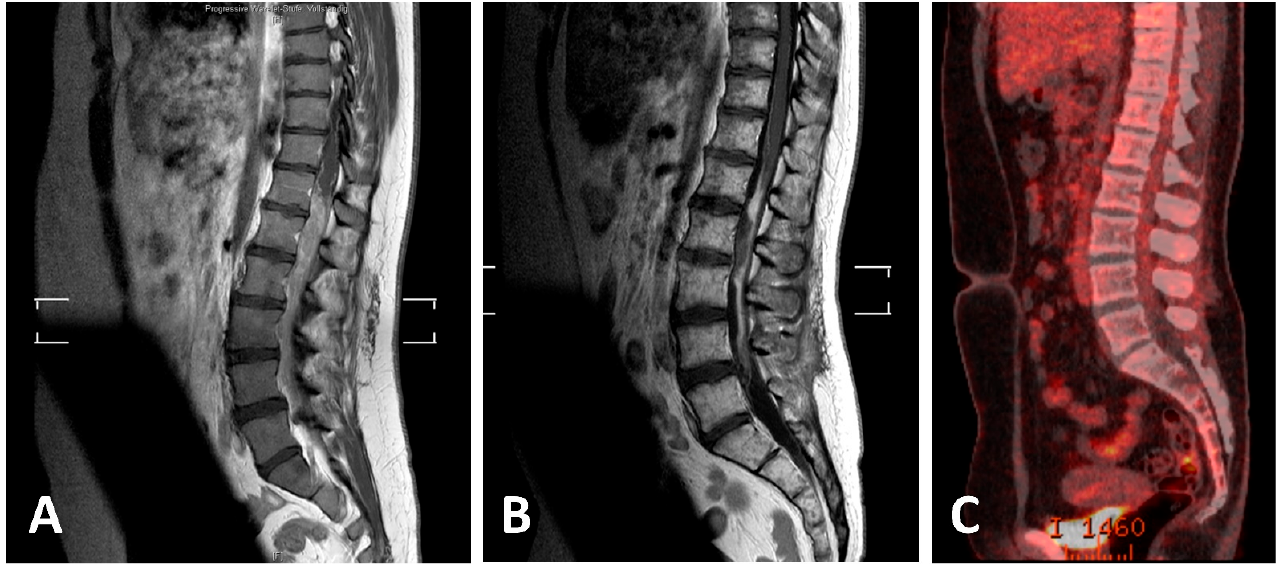
Figure 4. MRI and PET-CT scans of lumbar EwS before and after definitive RCth (radiochemother- apy) and ASCT (autologous stem cell transplantation). ( A ) Initial T1-weighted sagittal MRI of the thoracic and lumbar spine with intramedullary tumor; ( B ) T1-weighted sagittal MRI with residual post-therapeutic signal alterations; ( C ) post-therapeutic PET-CT scan with no residual increased FDG uptake.